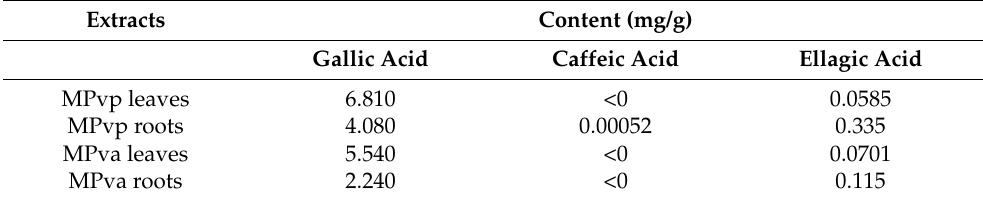
Table 2. Content of phenolic acids and polyphenol in MP aqueous extracts by using